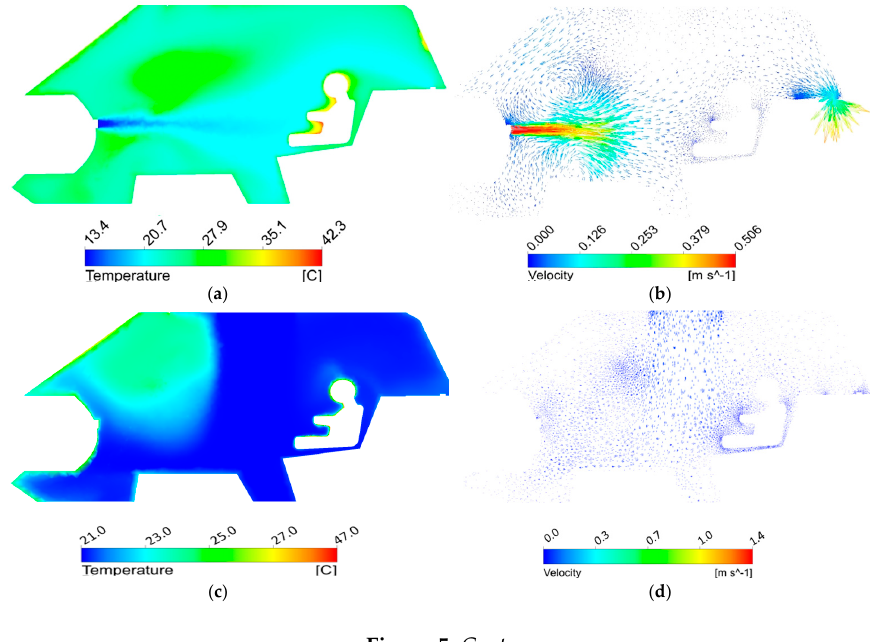
Figure 4. Cabin interior air temperature comparison for each considered case and previous results (adapted from [21]) for the cooling process.